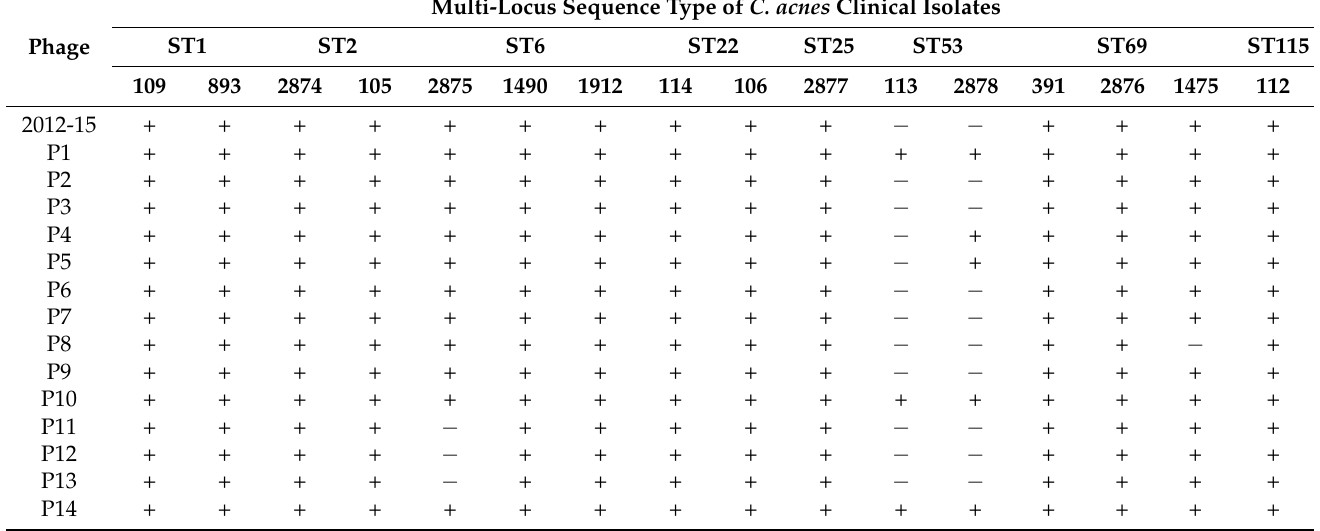
Table 1. Host range determination of C. acnes bacteriophages using the clinical isolates of C. acnes . Multi-Locus Sequence Type of C. acnes Clinical Phage